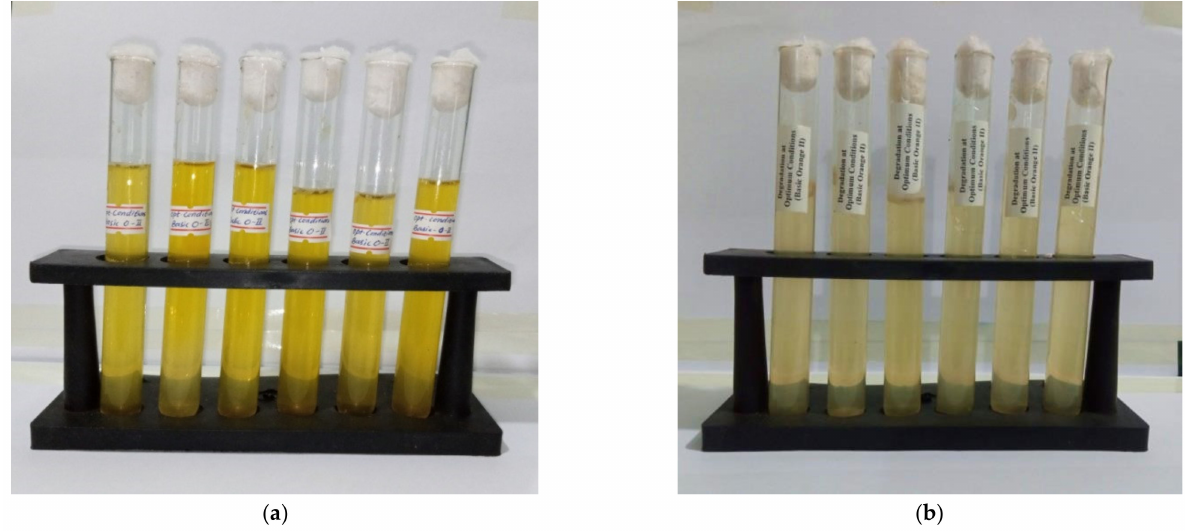
Figure 11. ( a ) Basic Orange 2 before Treatment of E. coli . ( b ) Basic Orange 2 after E. coli